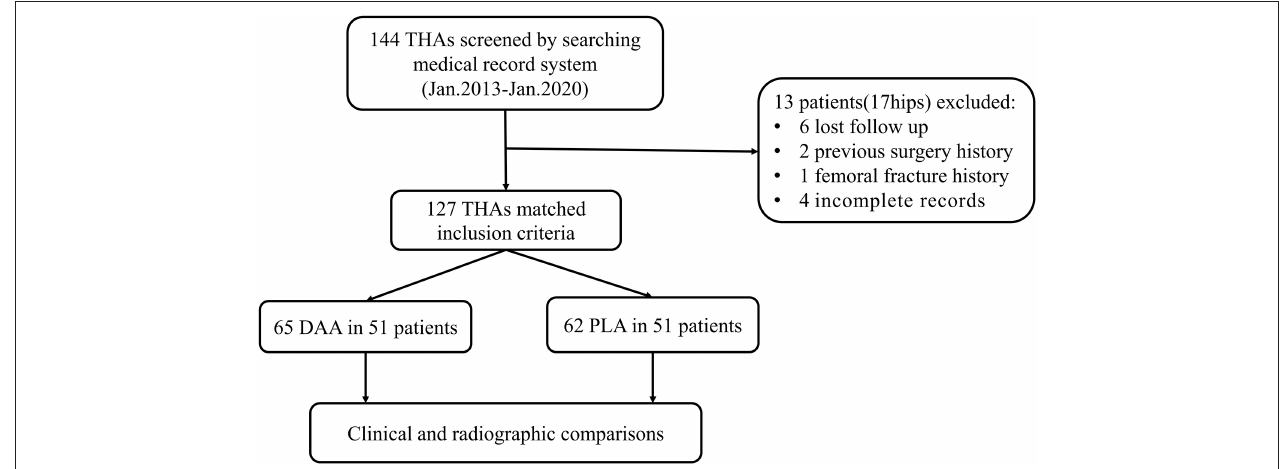
FIGURE 2 | Study design and flowchart.